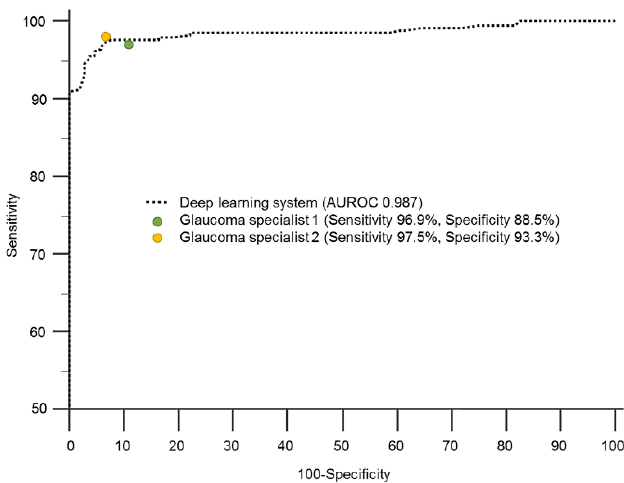
Figure 2. Area under the receiver operating characteristic curve (AUROC) of a deep learning system for glaucoma diagnosis based on a retinal nerve fiber layer thickness map of spectral-domain optical coherence tomography, in comparison with that of glaucoma specialists. Table 3. Diagnostic ability of deep learning system for diagnosing glaucoma based on retinal nerve fiber layer (RNFL) and ganglion cell–inner plexiform layer (GCIPL) spectral-domain optical coherence tomography maps when testing the internal validation set.